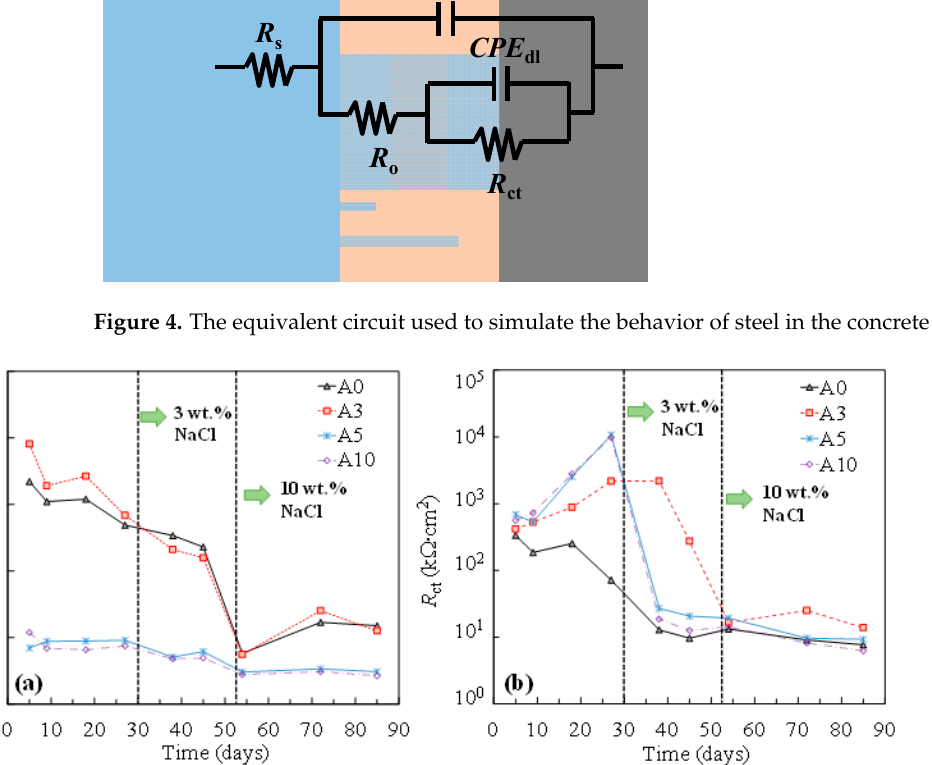
Metals 2022 , 11 , x FOR PEER REVIEW Figure 5. Resistance of oxide film ( a ) and charge transfer ( b ) of steel specimens at various stress levels.